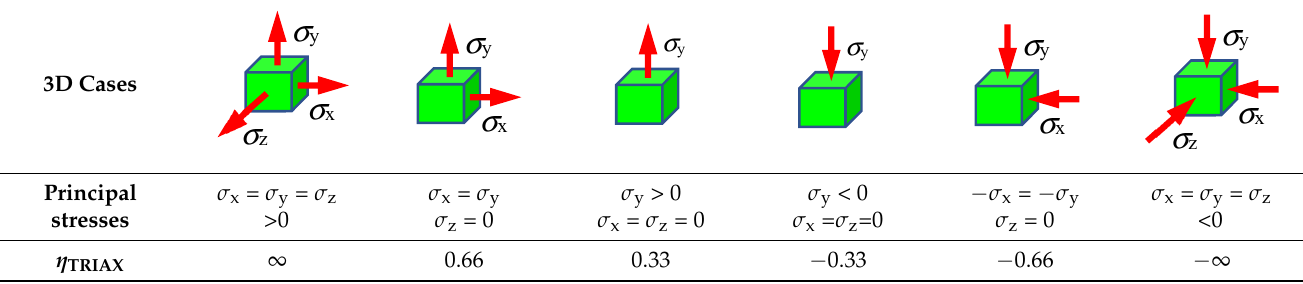
Figure 9. Failure diagram on the true characteristics of HY 80 steel ( σ true - ε true ). The material fracture occurs in point 4 after reaching the value of the fracture defor- mation 𝜀 (cid:3033)(cid:3028)(cid:3036)(cid:3039)(cid:3048)(cid:3045)(cid:3032)(cid:3043)(cid:3039) . However, if during the degradation of the material on the curve 2–4 the